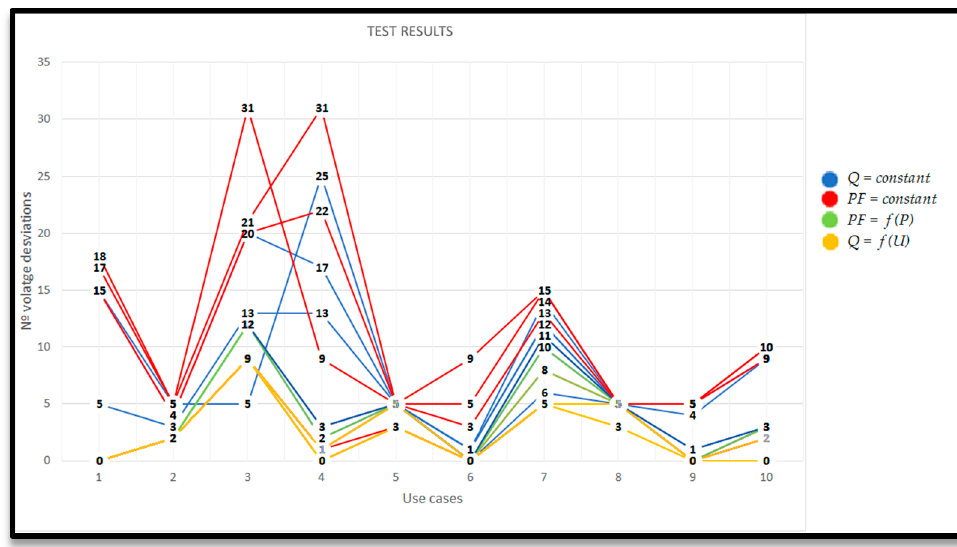
Figure 15. Results all controls: Voltage deviations.